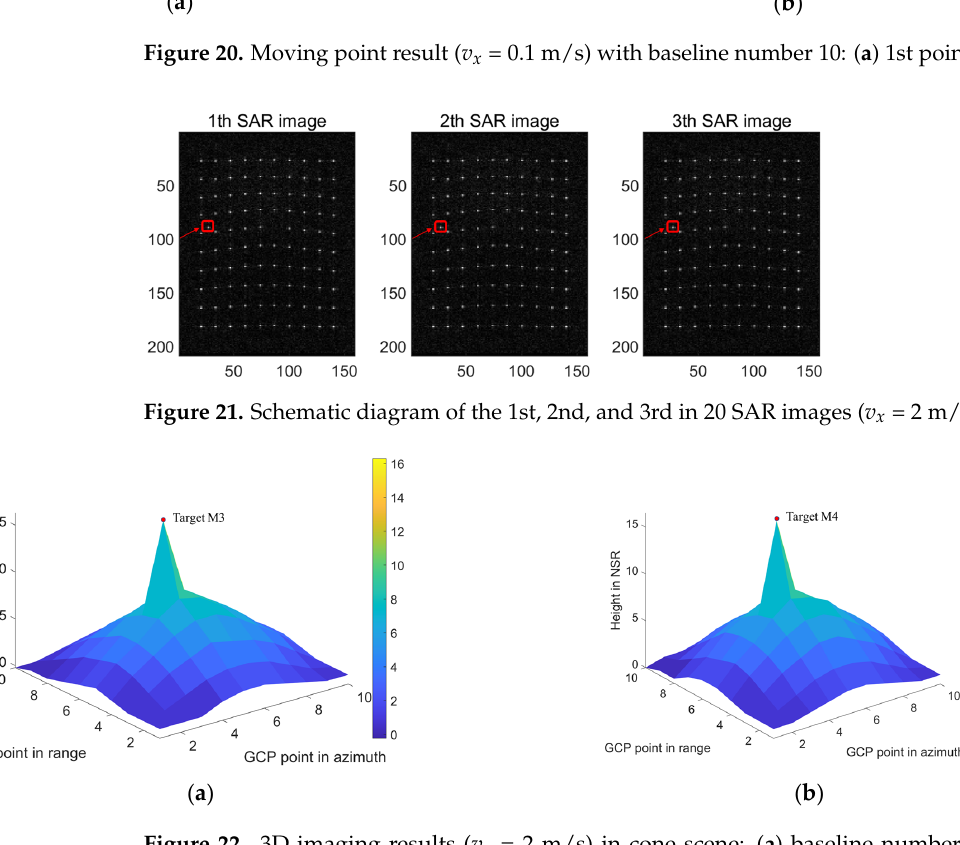
Figure 22. 3D imaging results ( v x = 2 m/s) in cone scene: ( a ) baseline number 20; ( b ) baseline number 10.